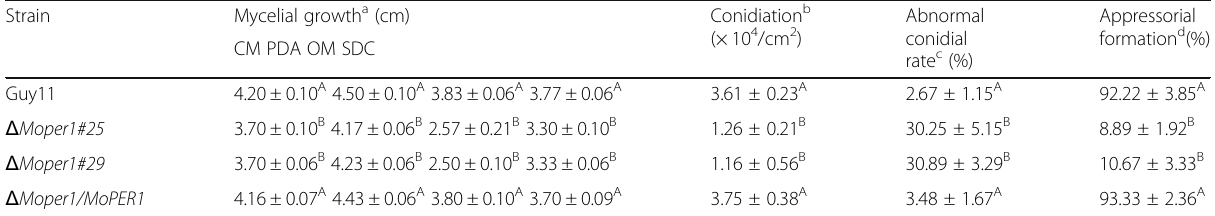
Table 1 Comparison of mycological characteristics among strains